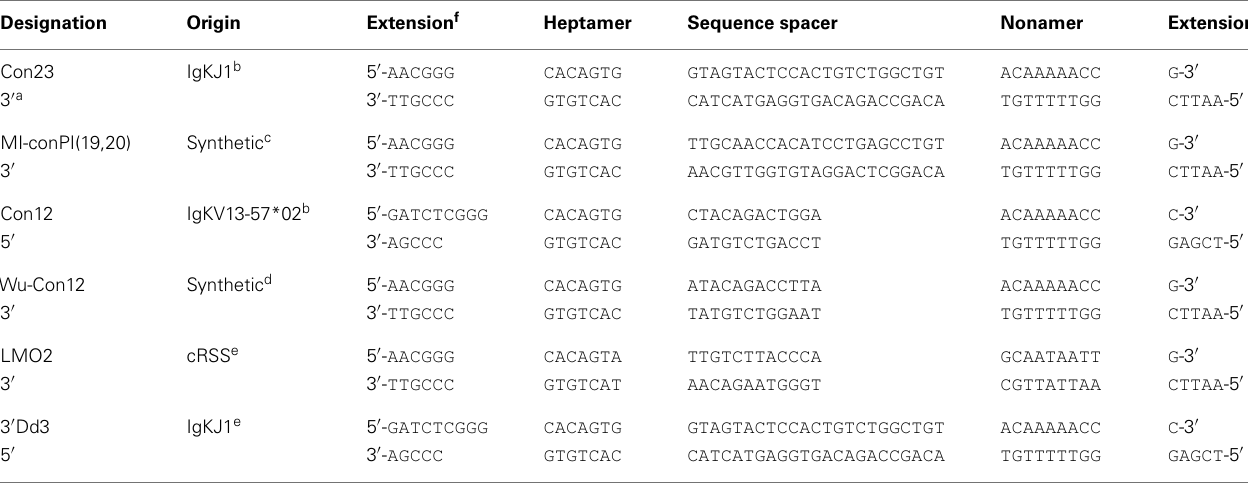
Table 2 | Oligonucleotides used to construct the GFPi-CFP